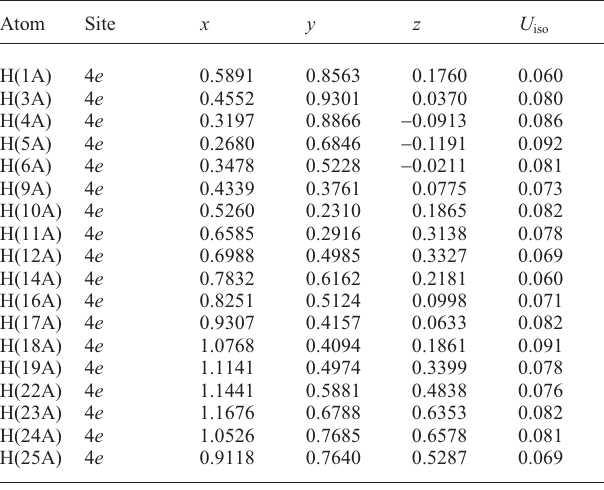
Table 2. Atomic coordinates and displacement parameters (in Å 2 )